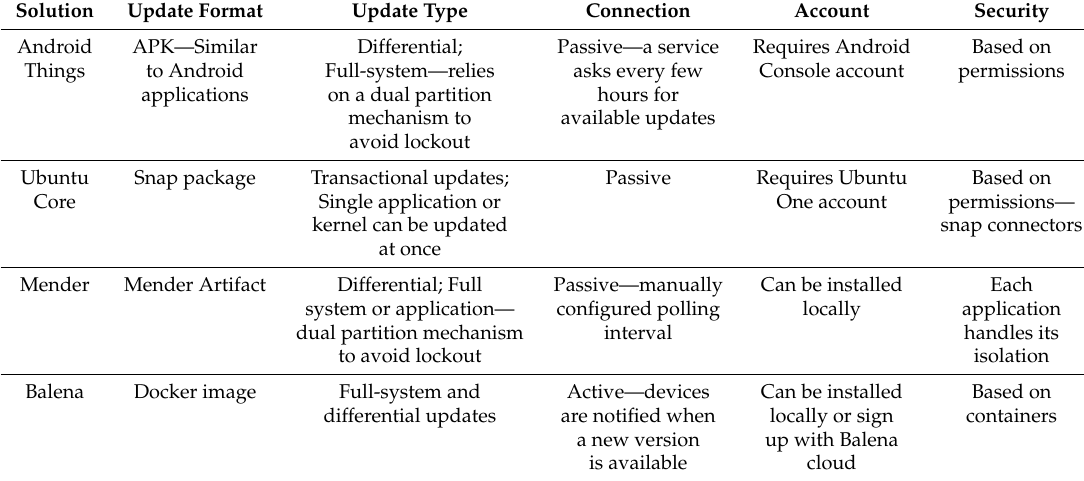
Table 1. Commercial IoT deployment solutions and their